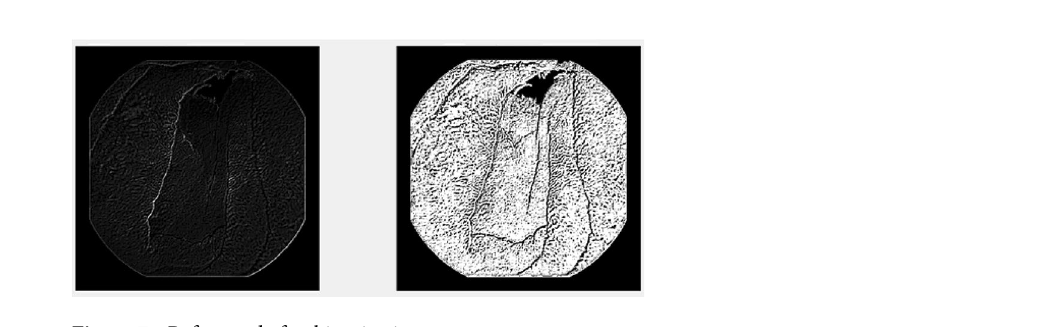
Figure 7. Before and after